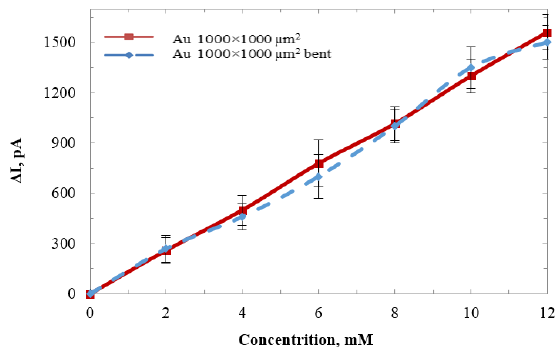
Figure 13. Sensitivity comparison between the sensor in the flat condition and when it was bent.